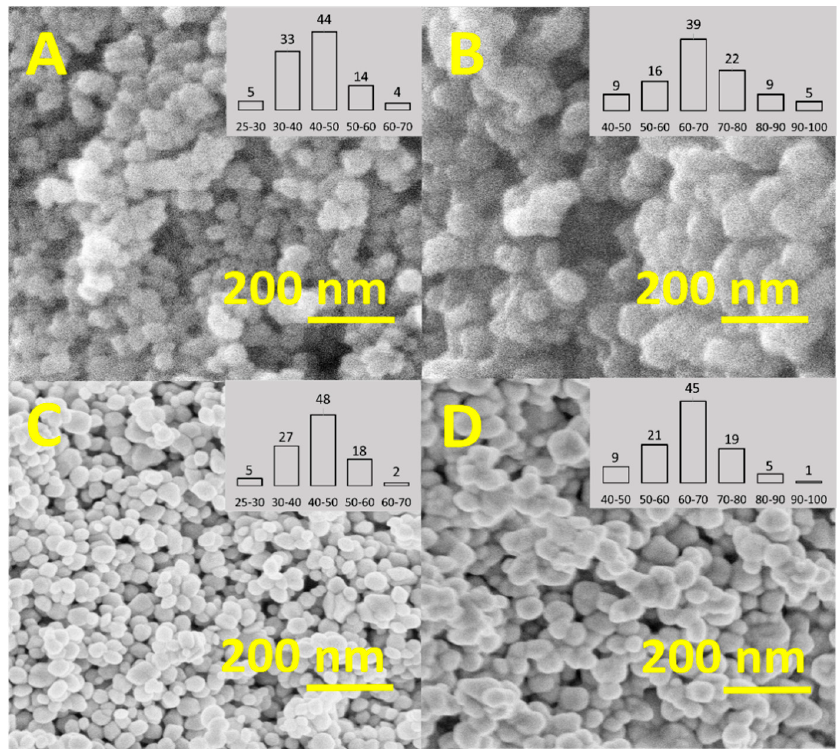
Figure 2. SEM observation of α -Fe 2 O 3 NPs prepared with different concentrations of Fe (III) ni- ( A ) 0.05 M ( α -Fe 2 O 3 - p 45), ( B ) 0.1 M ( α -Fe 2 O 3 - p 70), and after α -Fe 2 O 3 NPs coating with the citrate, ( C ) 0.05 M ( α -Fe 2 O 3 - n 45), ( D ) 0.1 M ( α -Fe 2 O 3 - n